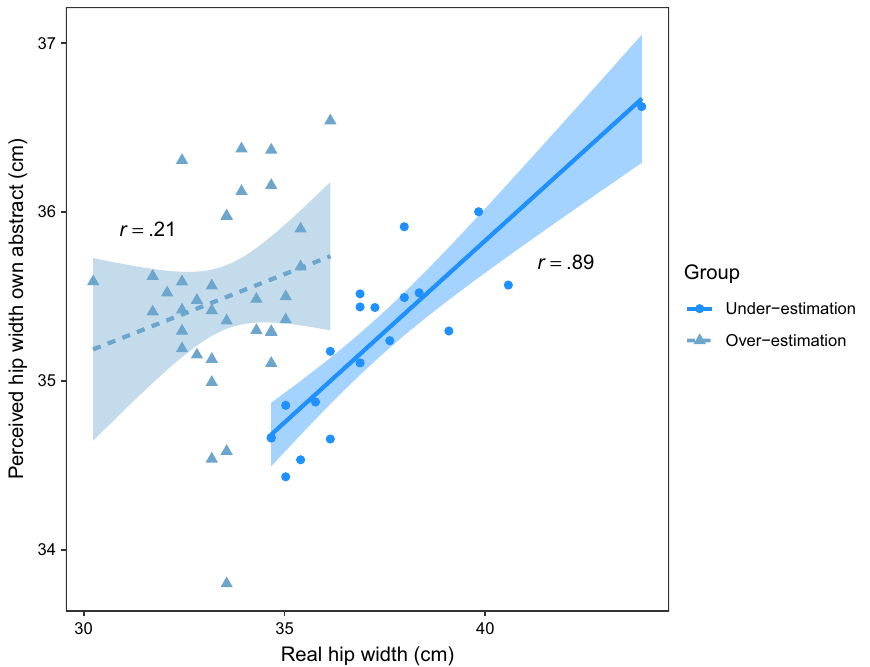
Figure 2. Correlations between real and perceived hip width for under- versus over-estimators. Correlation between real and perceived hip width in the own abstract condition ( Which of these two bodies looks most like your own? ), for under- (perceived hip width smaller than real hip width) versus over-estimators (perceived hip width bigger than real hip